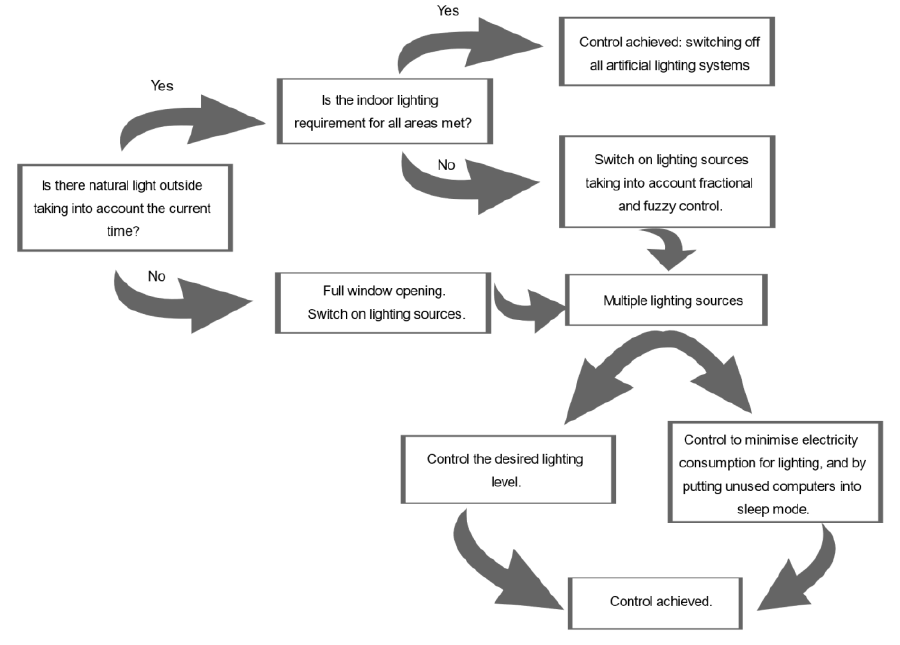
Figure 1. Electricity control strategy for the case of the present work.